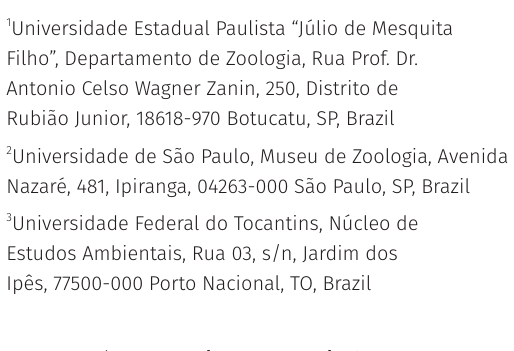
Table SI. Classification of chironomids and armored catfishes ( sensu Fricke et al. 2019a, b) from the Guareí River Basin, São Paulo,